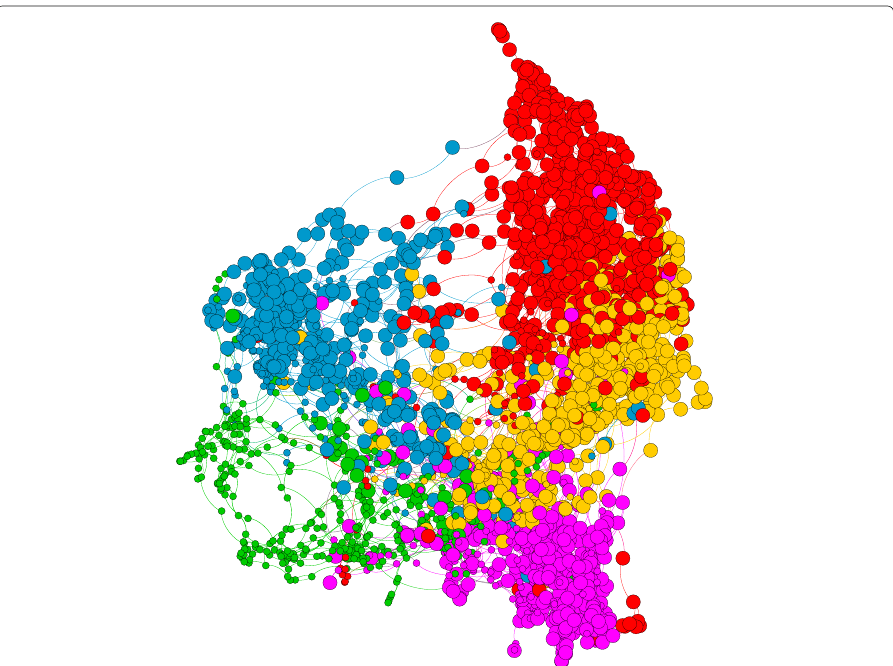
Fig. 3 Visualization of optimal clustering result for kNN2 Tenacity 5-cluster graph in terms of distribution of high overall IQ ( ≥ 70) vs. lower IQ ( < 70). Large circles denote high IQ while small circles denote low IQ. Only green cluster shows a high concentration of low IQ nodes. This demonstrates that the clustering obtained is a combination of various factors, not just IQ scores